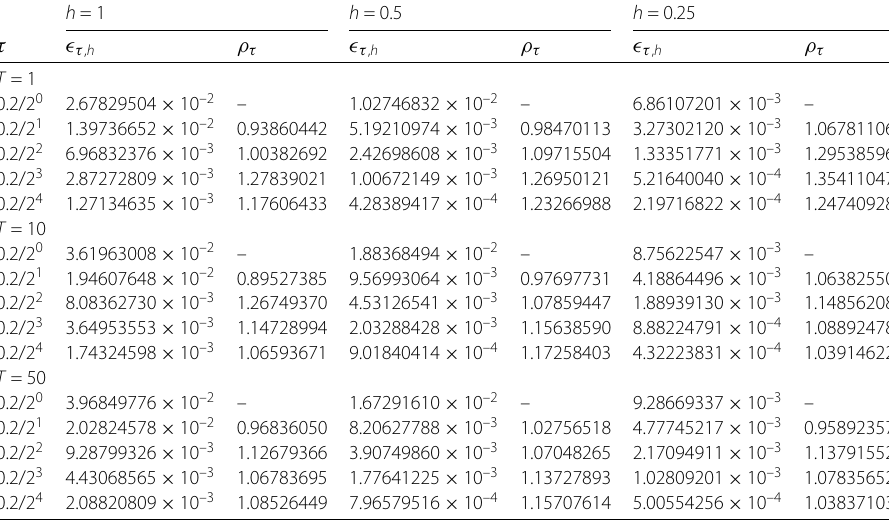
Table 4 Table of absolute errors in the maximum norm and temporal rates of convergence for various values of the parameters τ and h . We used f ( u ) = u (1 – u ), and the exact solution (58) of model (46). We employed also Ω = (–200,200) and various values of T h = 1 h = 0.5 h =